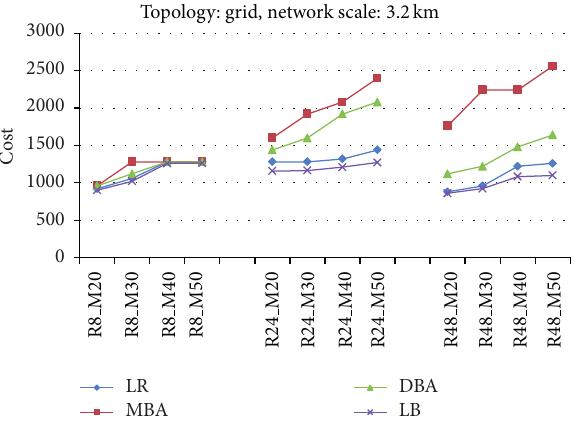
Figure 7: Deployment cost with different number of RS and MS (1BS, grid, 3.2 km).